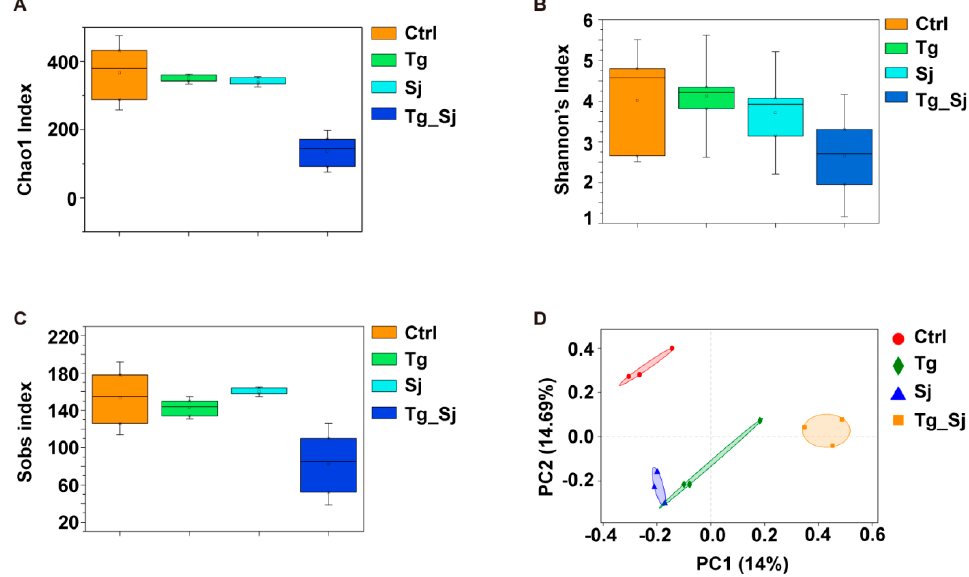
Figure 5. Diversity comparison of bacterial community in different groups. The gut microbial profiles of mice ordinated by alpha diversity analysis based on the ( A ) Chao1 index, ( B ) Shannon’s index, ( C ) observed species (Sobs) index among groups control (Ctrl), T. gondii (Tg), S. japonicum (Sj)-infected and co-infected (Tg_Sj) groups. ( D ) Beta diversity analysis based on bray curtis in different groups.